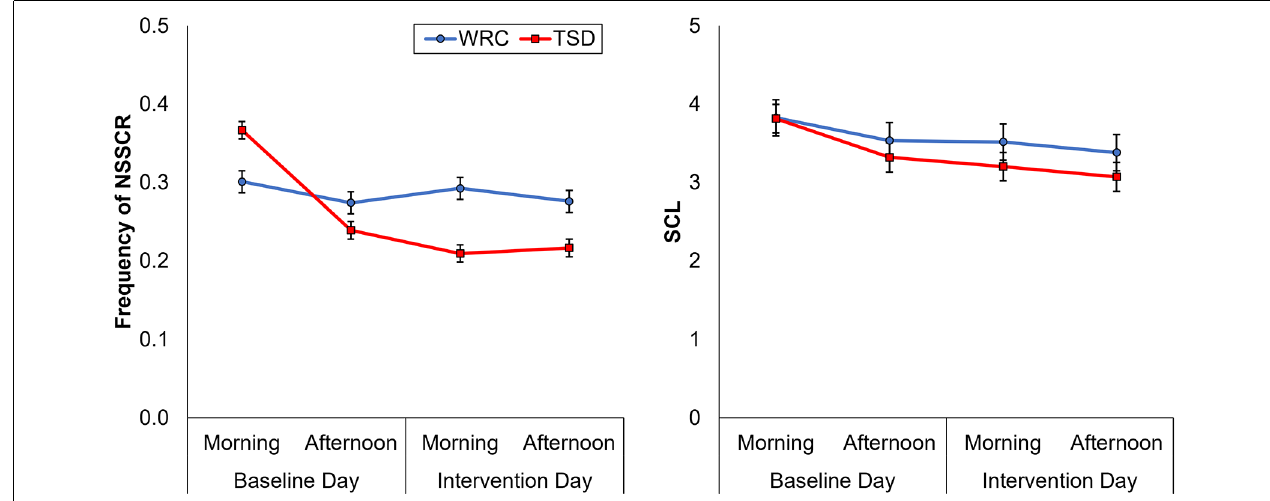
FIGURE 2 | Changes in frequency of non-specific skin conductance responses (NSSCR; left) and skin conductance level (SCL; right), from the baseline day (morning and afternoon) to the intervention day (morning and afternoon). In each panel, downward corresponds to less physiological arousal; error bars represent ± 1 standard error of the mean.